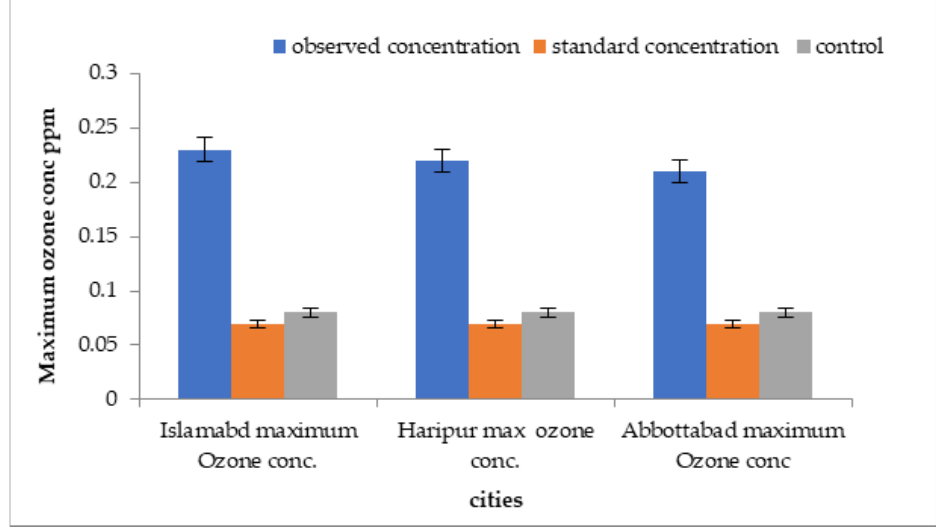
Figure 13. Comparison of mean concentrations of ozone with control sites and WHO standard val- ues in three megacities of Pakistan.